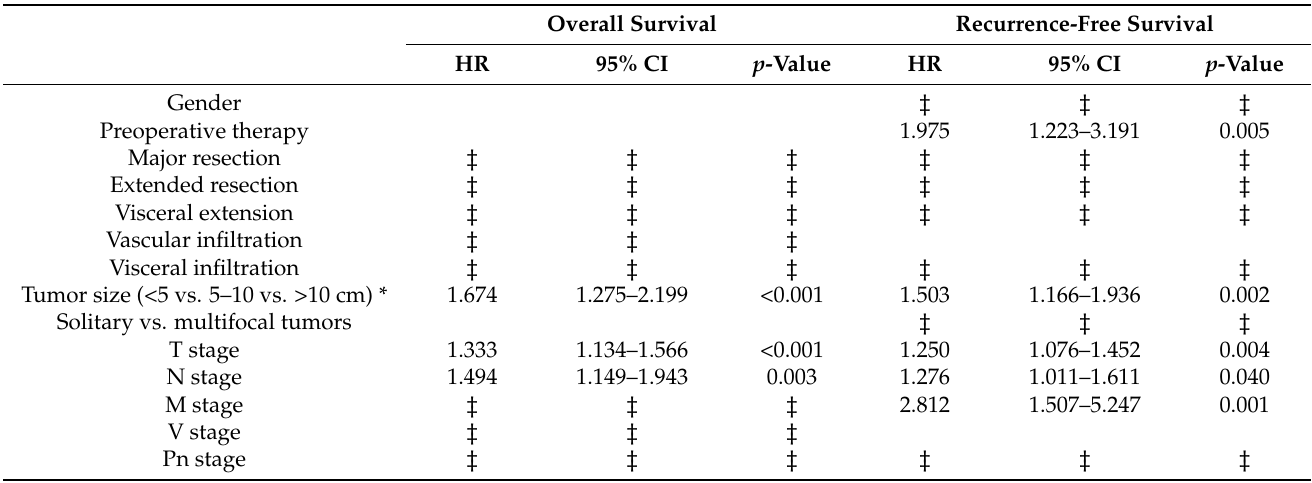
Table 7. Predictors of